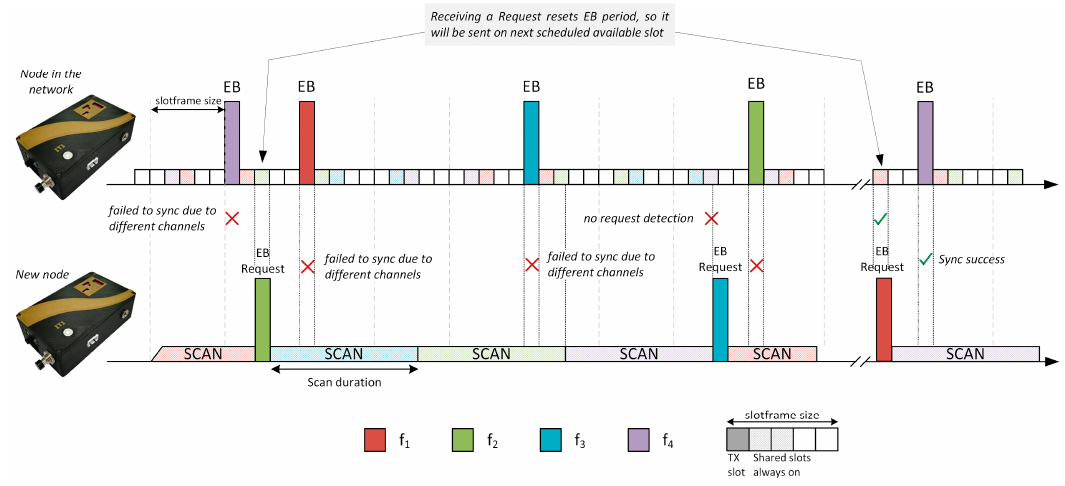
Figure 2. Active scanning method implemented for TSCH.